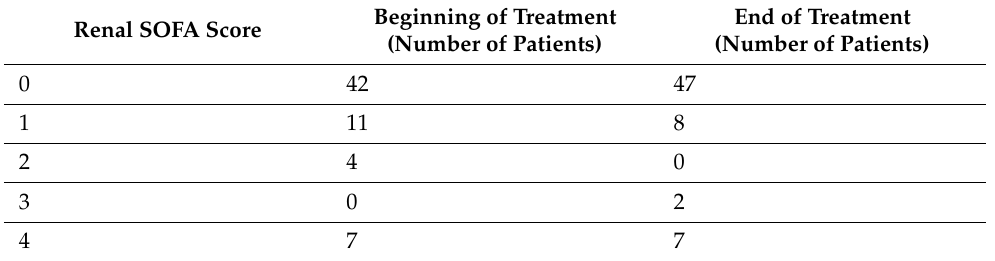
Table 6. Distribution of renal SOFA scores.